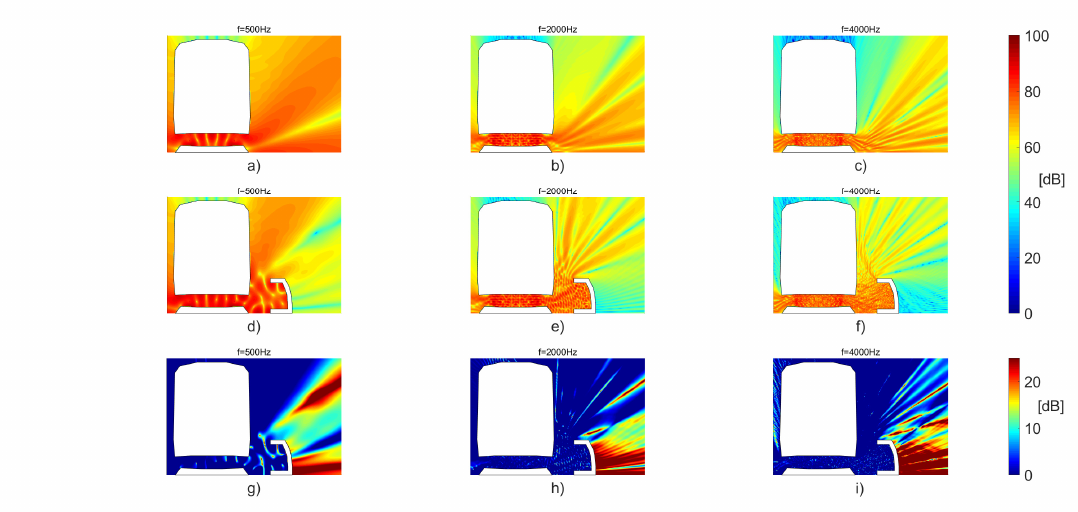
Figure 16. Comparison of the sound pressure levels in the cases without ( a – c ) and with the barrier ( d – f ) and the respective insertion loss, first, second, and third rows ( g – i